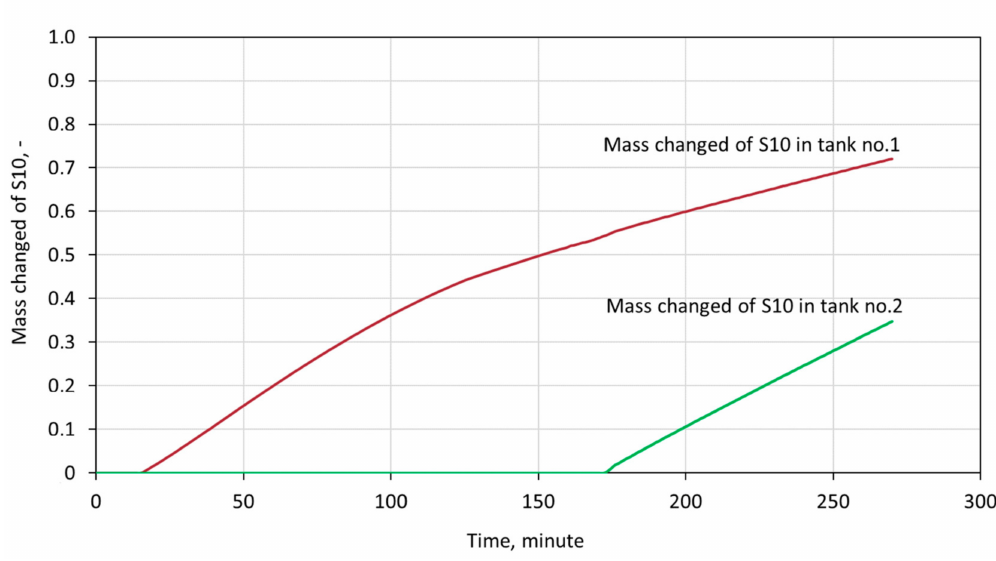
Figure 7. Mass fraction of the liquid phase of the S10 in the storage tanks during their